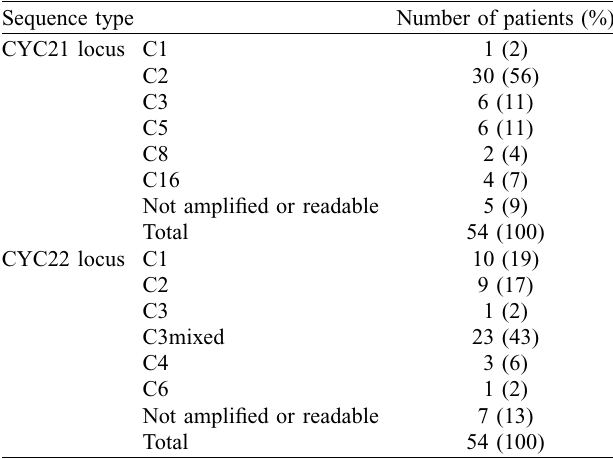
Table 1. Sequence types identi fi ed in 58 Cyclospora -positive specimens from 54 patients 1